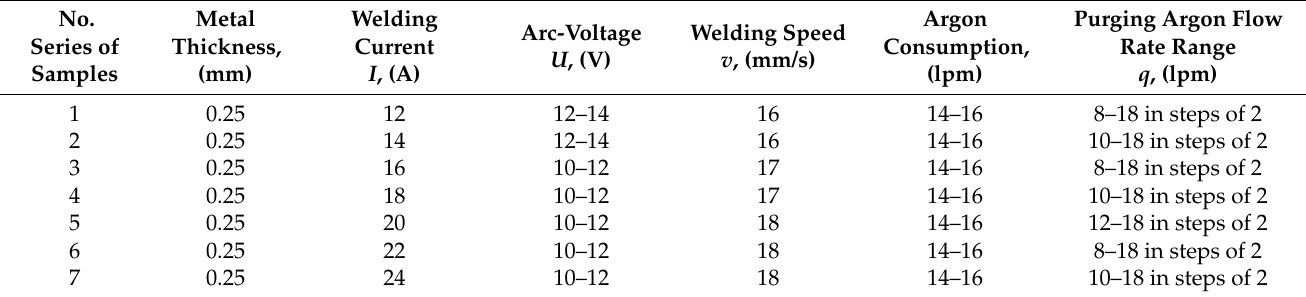
Table 2. Parameters of changing the welding modes of the AISI 316Lsteel